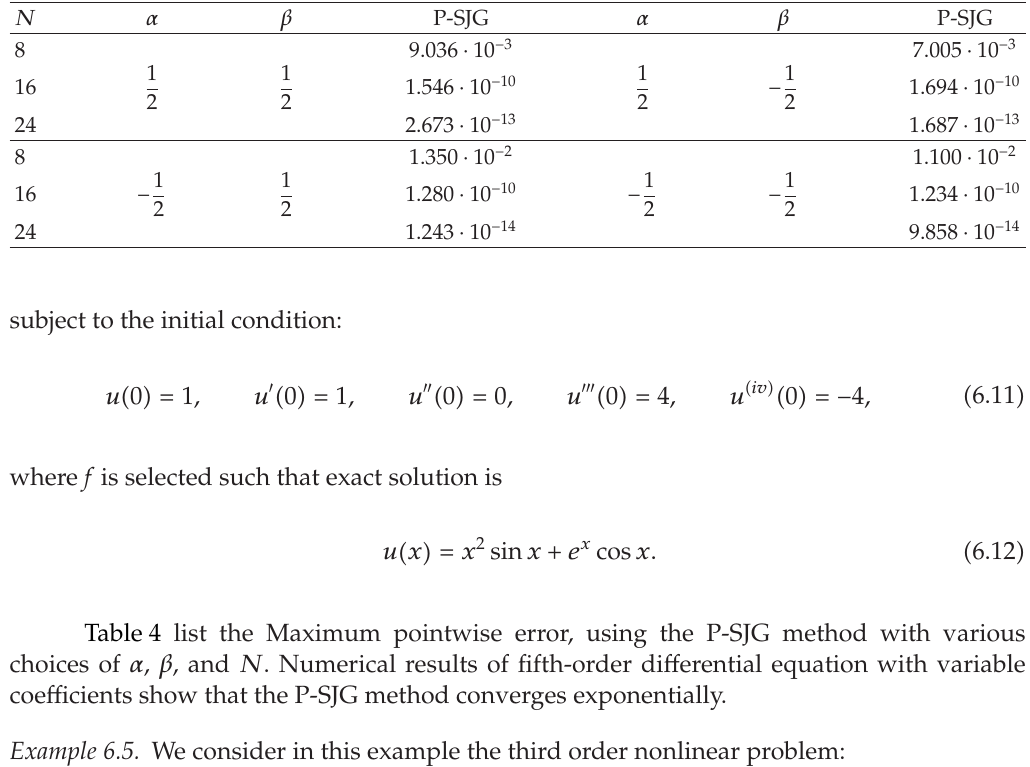
Table 4: Maximum pointwise error using P-SJG method for N (cid:9) 8 , 16 , 24 for Example